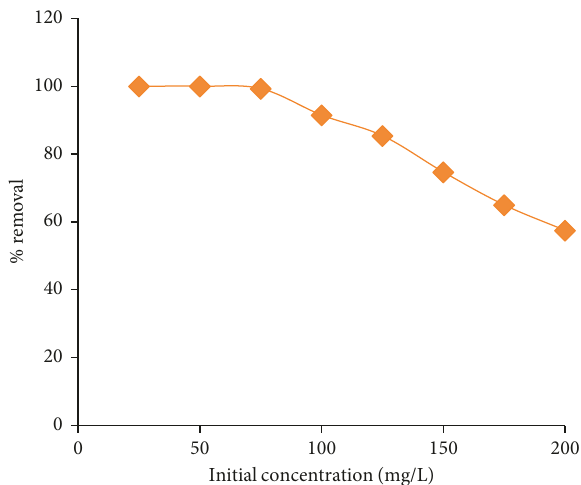
Figure 10: Effect of initial concentration on adsorption of lead.